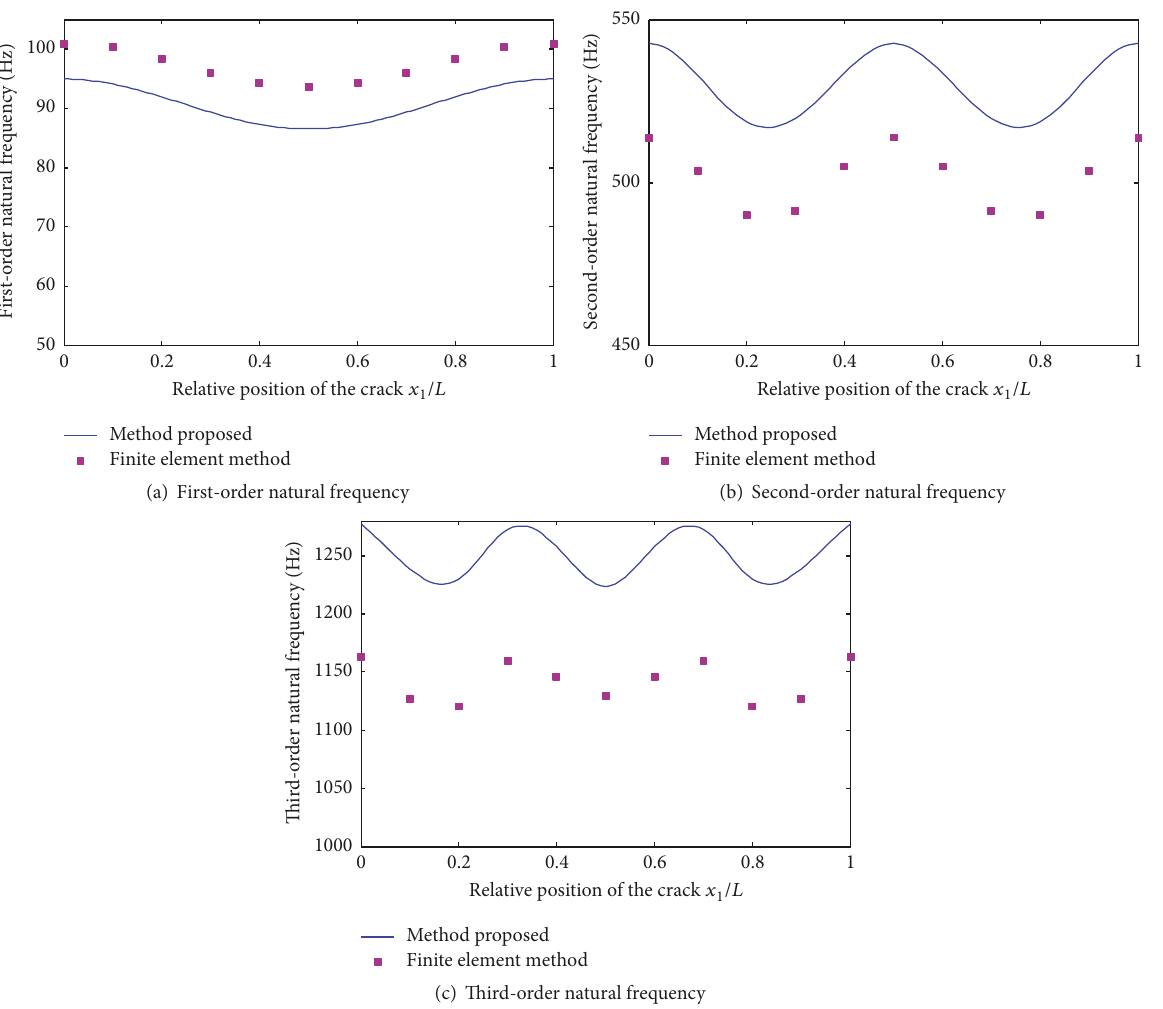
Figure 4: Comparison of the first three-order natural frequencies obtained by two